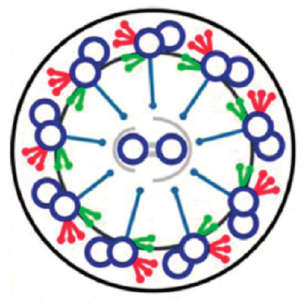
Figure 3. Diagram of a cross section of a cilium. Outer arm dyneins in red; inner arm dyneins in green; doublets of microtubules in blue; radial spokes connecting central pair to outer doublets. Adapted from [30], with